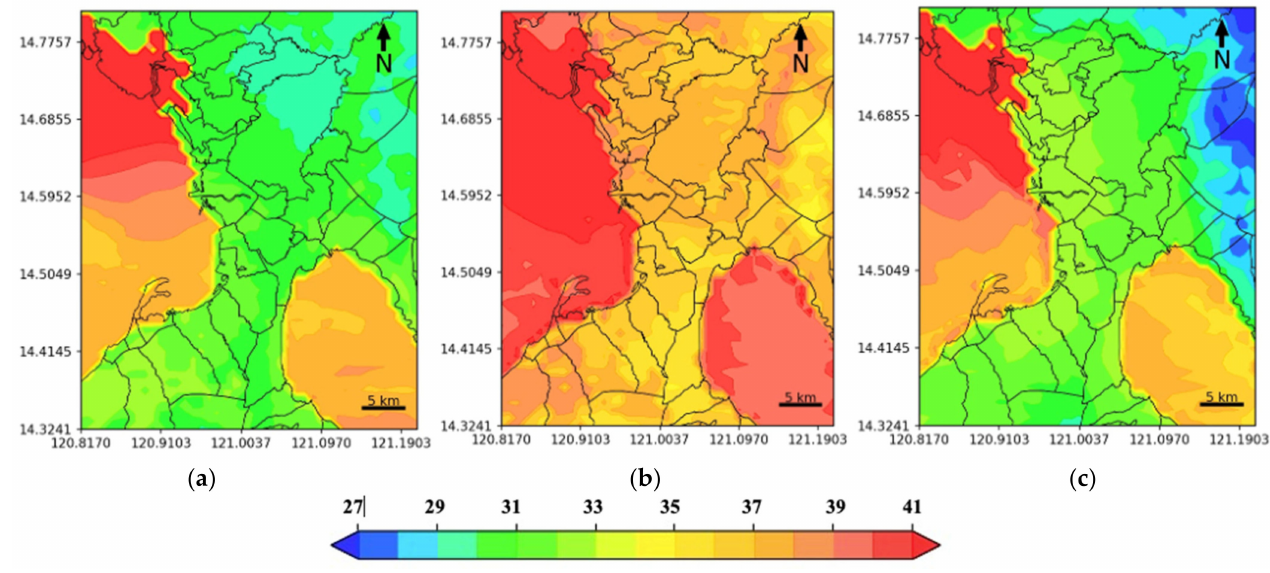
Figure 8. Averaged heat index ( ◦ C) simulated by BEM on 22–28 April 2018. ( a ) 8:00, ( b ) 14:00, and ( c )